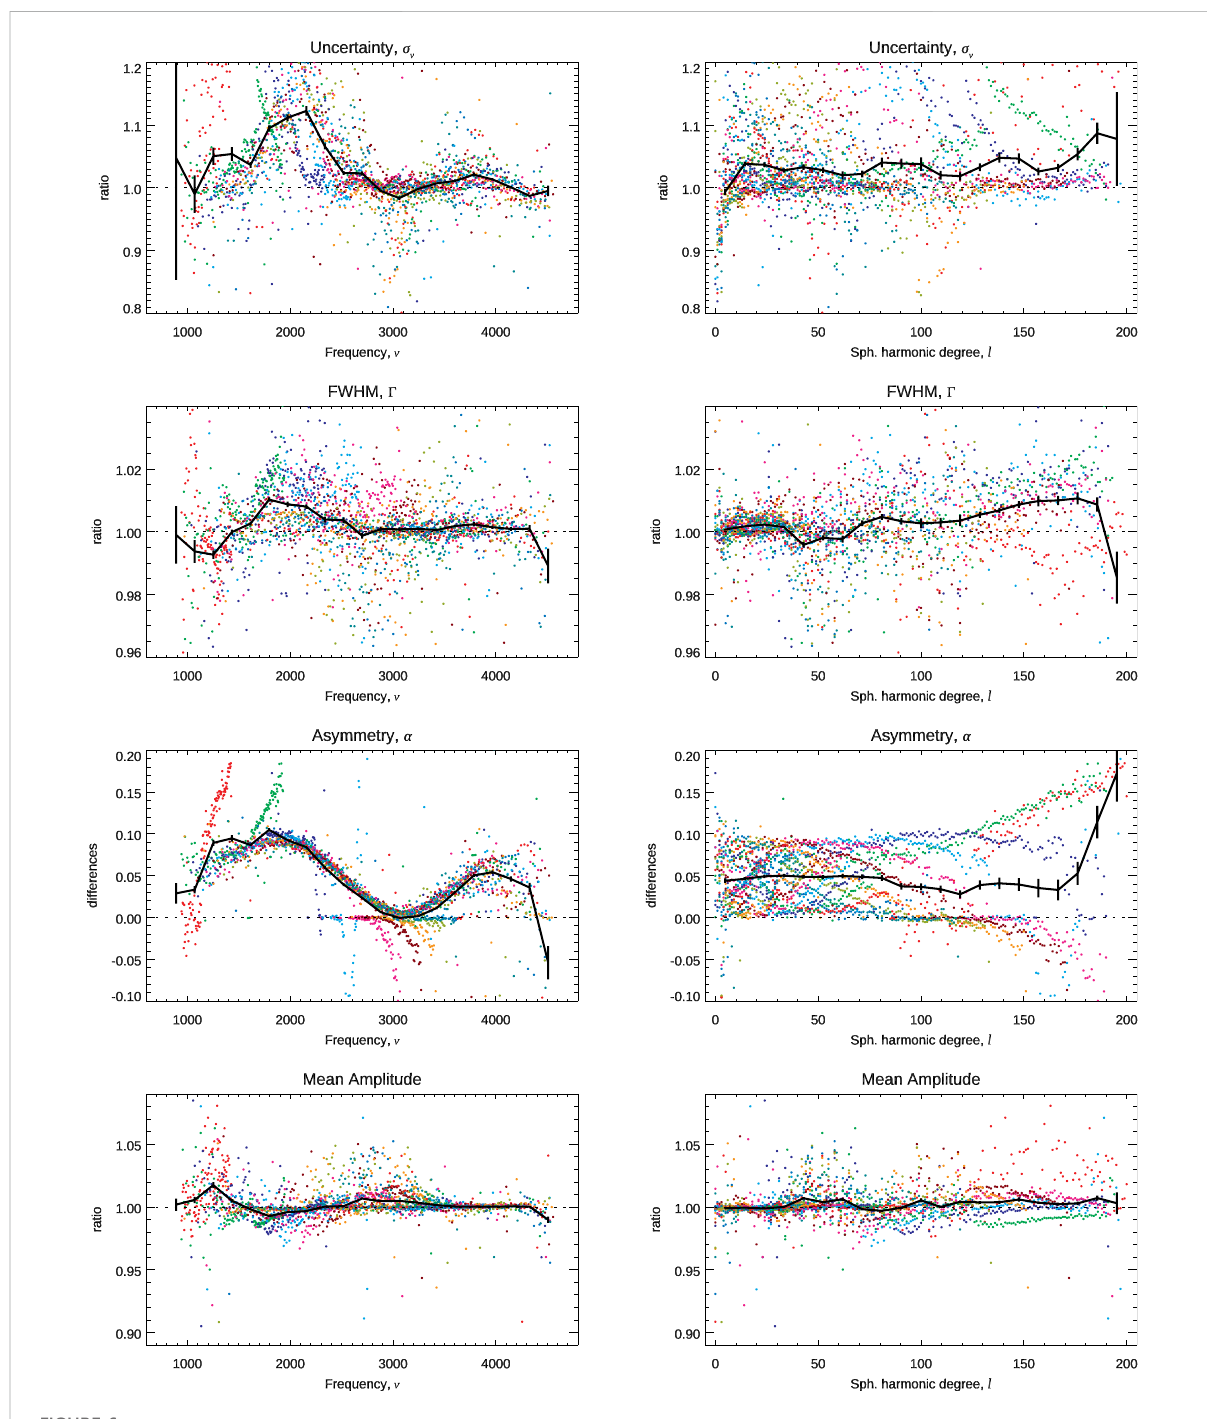
FIGURE 6 Comparison of mode characteristics, σ ] , Γ , α , and (cid:2) A ratios or differences, when fi tting symmetric or asymmetric mode pro fi les, using the same leakage